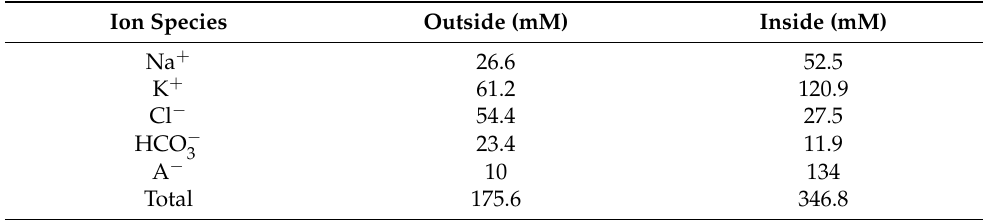
Table 2. Extra- and intraneuronal ion concentrations for the Donnan equilibrium at α = 0.25.